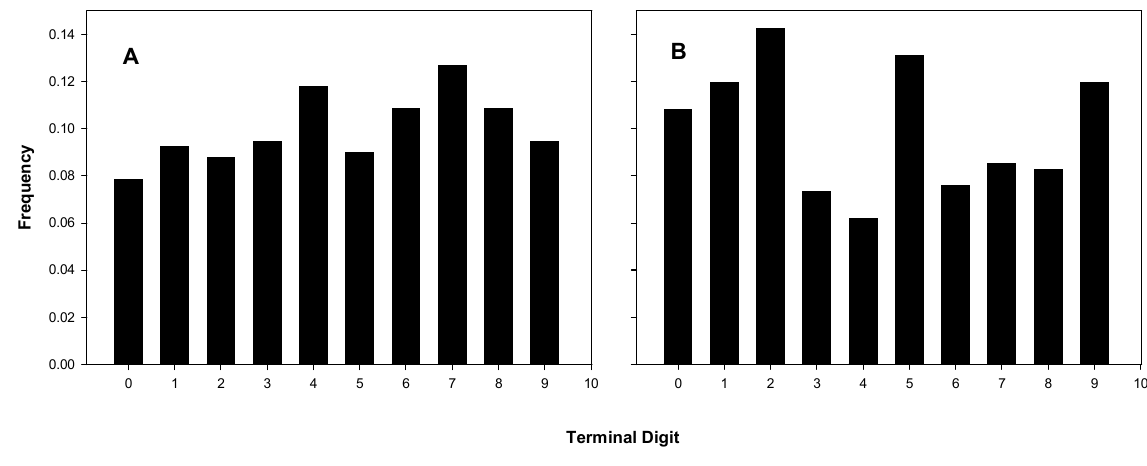
Figure 2. Terminal digit distributions for coulter counts. ( A ) B’s and C’s Coulter digit distributions, chi-square for fit to uniform, p = 0.462; ( B ) A’s Coulter digit distributions, chi-square for fit to uniform, p = 4.49 × 10 − 4 .